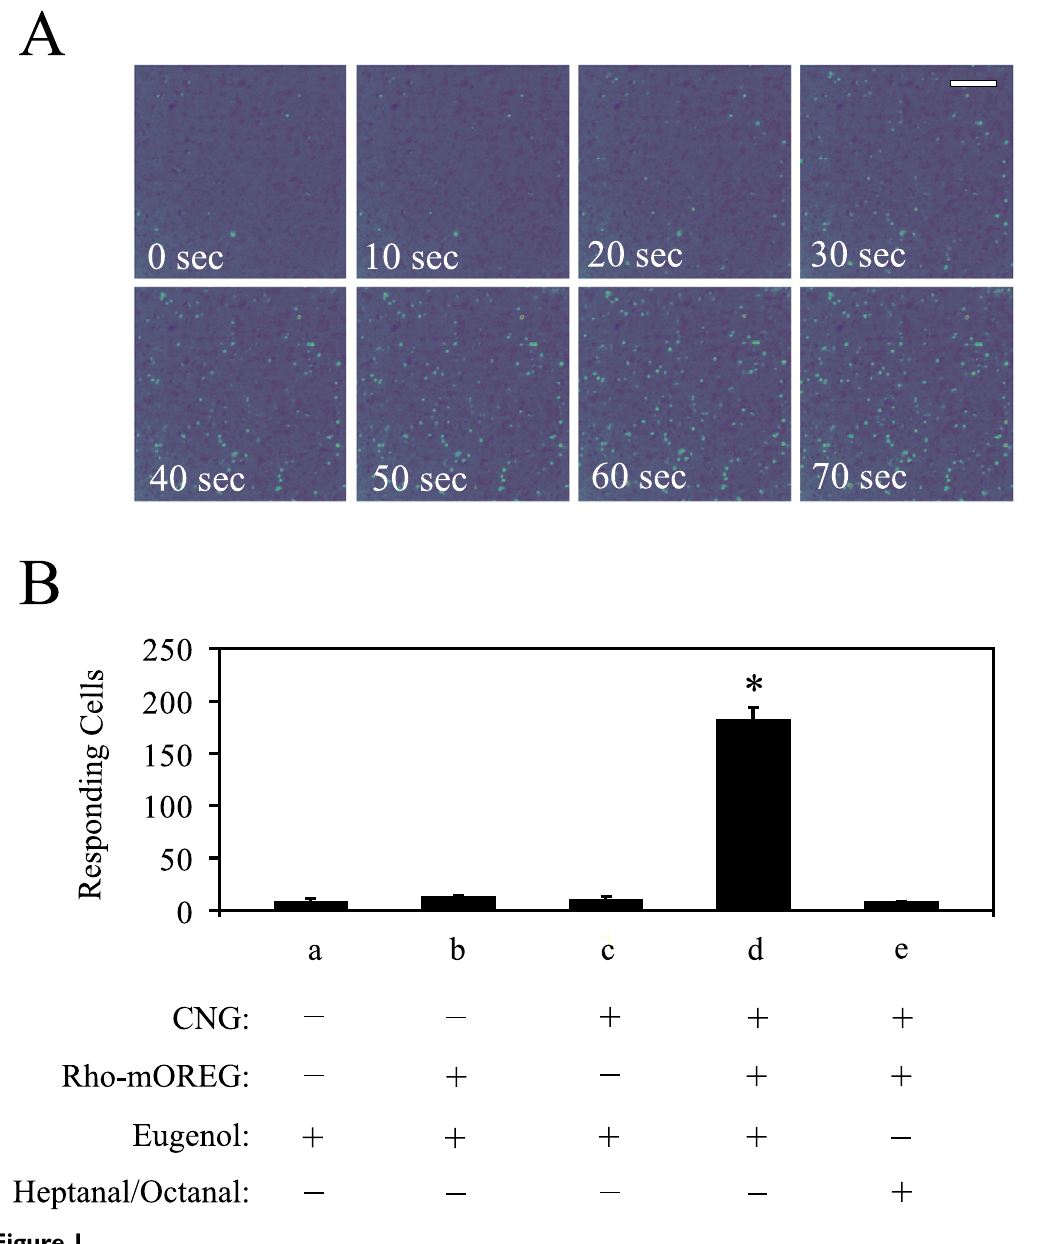
Figure 1 Functional expression of Rho-mOREG using a CNG-based assay. (A) HEK293 cells transiently transfected with Rho- mOREG and CNG were assayed for increases in intracellular calcium in response to 100 uM eugenol. Images contain ~2000 confluent cells and represent responses at the indicated times following odorant stimulation. Scale bar is 300 um. Responses were observed in ~10% of total cells or ~20% of transfected cells (~50% transfection efficiency). (B) Quantitation of cells expressing vector only (a), Rho-mOREG only (b), CNG only (c), Rho-mOREG and CNG (d and e) following stimulation